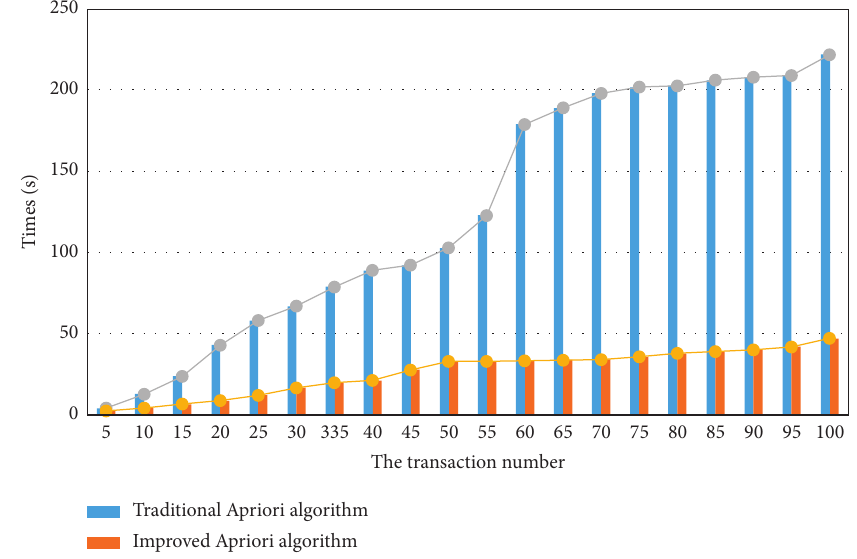
Figure 5: Comparative analysis results of different transaction database experiments.